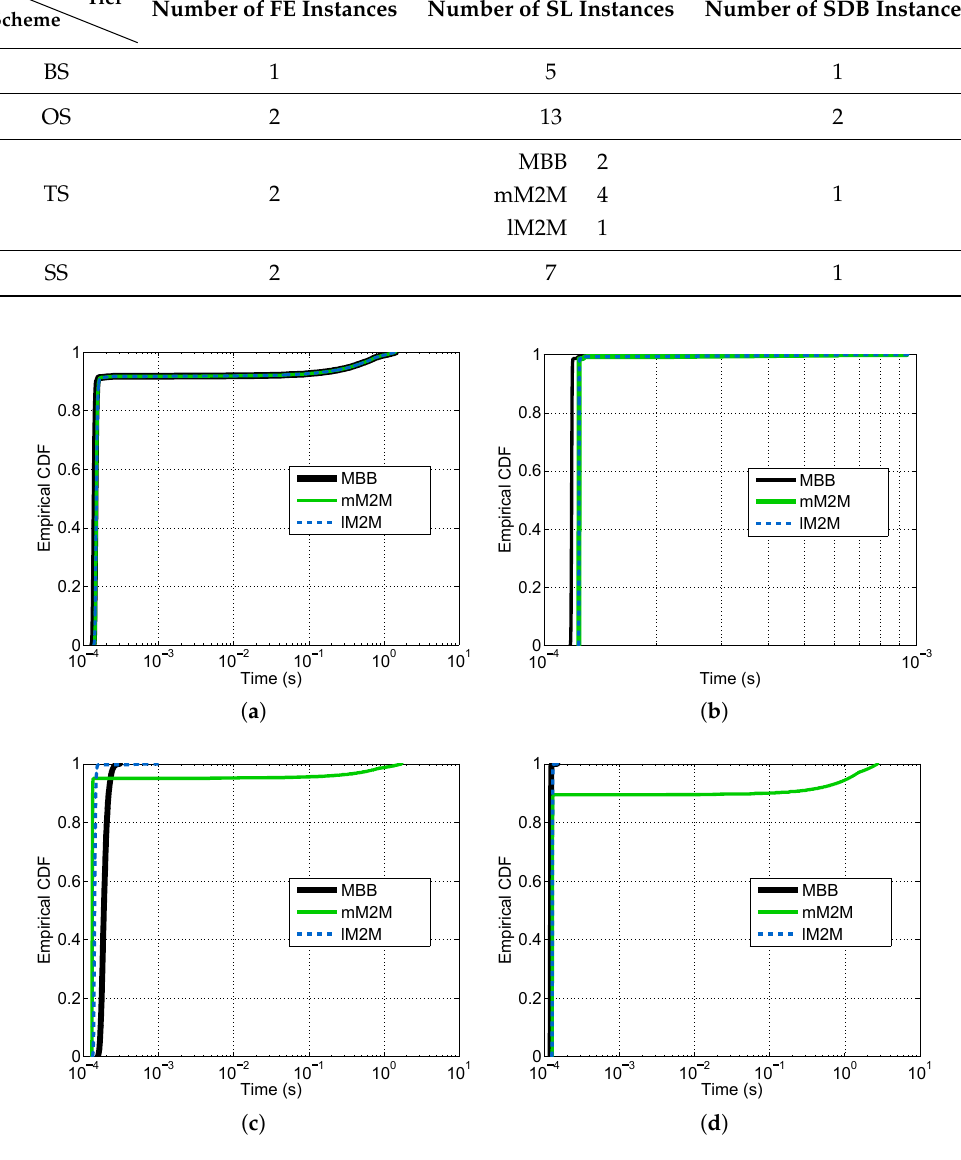
Figure 13. CDF of the filtered vMME delay for each scheme (ten M2M devices per MBB UE). ( a ) Baseline scheme; ( b ) Overdimensioned scheme; ( c ) Traffic separated scheme; ( d ) Traffic shaper